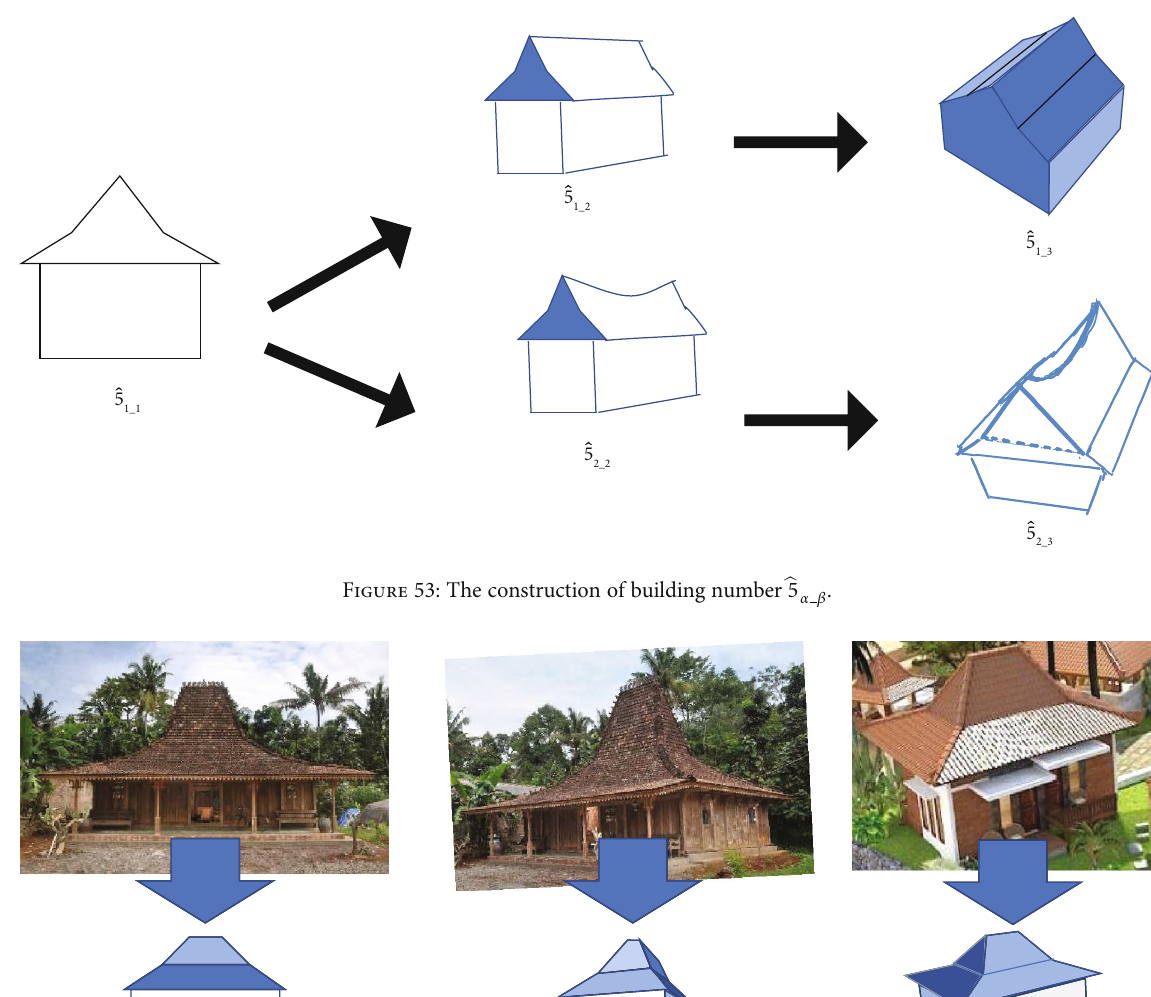
Figure 54: Building number ̂ 6